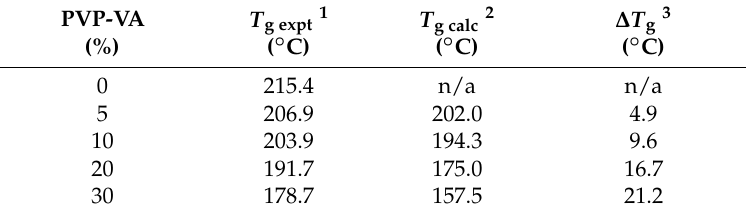
Figure 6. Total heat flow curves of RBM crystals and SGR granules with 0 − 30% PVP-VA by DSC. Table 3. Measured and calculated glass transition temperatures of SGR granules.